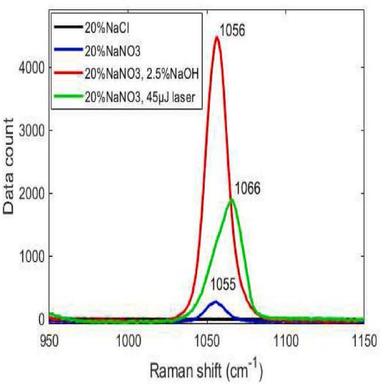
Raman spectra of the reaction products indicating increase in nitrate content with LECM in 20% NaNO3 and further increase with ECM in 20% NaNO3 with 2.5% NaOH.